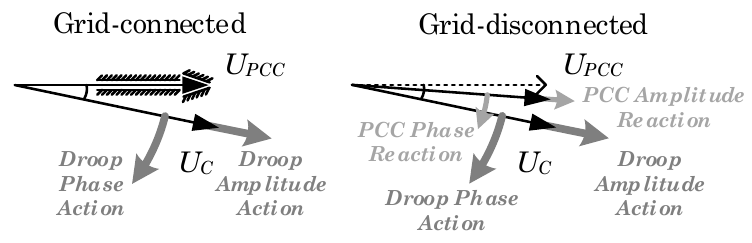
Figure 4. Vectorial representation of droop control under a grid